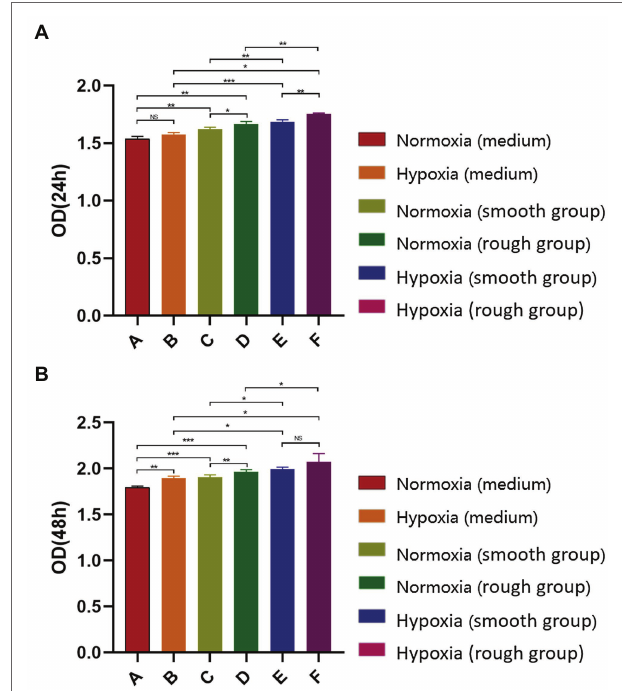
FIGURE 2 | Detection of MG-63 cell proliferation rate using a CCK-8 kit. (A) MG-63 cell proliferation rate at 24 h and (B) MG-63 cell proliferation rate at 48 h. NS, no significance; * p < 0.05, ** p < 0.01, and *** p <